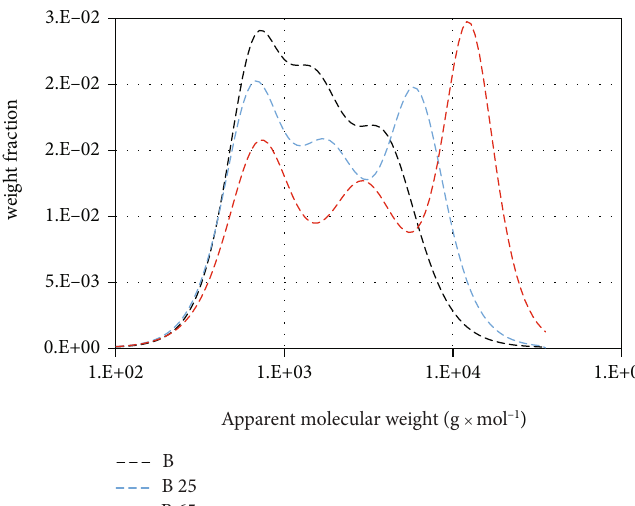
Figure 7: AMWD of B at di ff erent levels of aging.